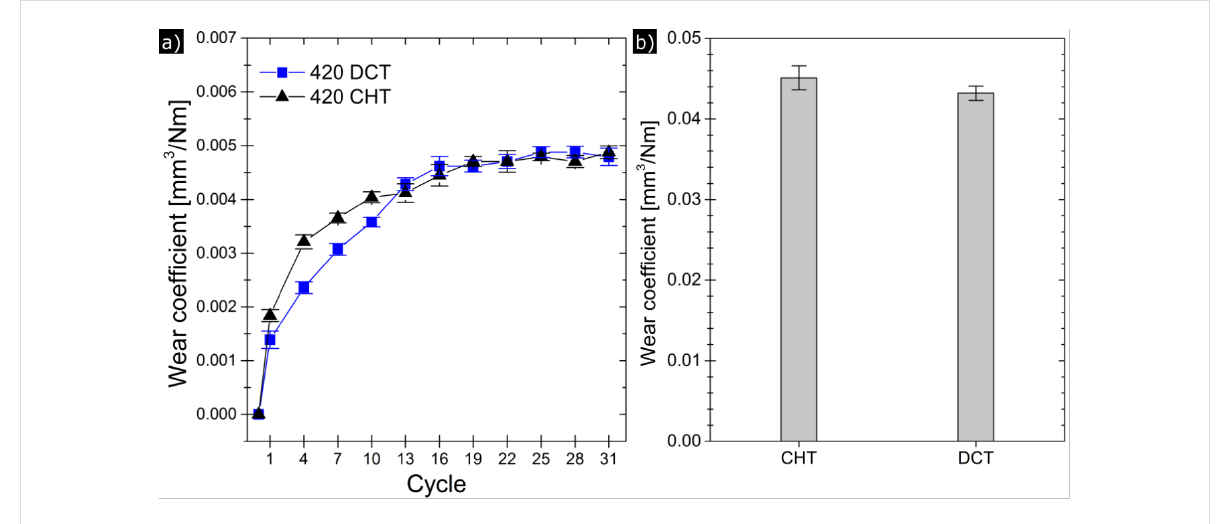
Figure 5: a) Evolution of wear coefficient during the tests at 1000 μ N of applied normal load and b) cumulative wear coefficient.